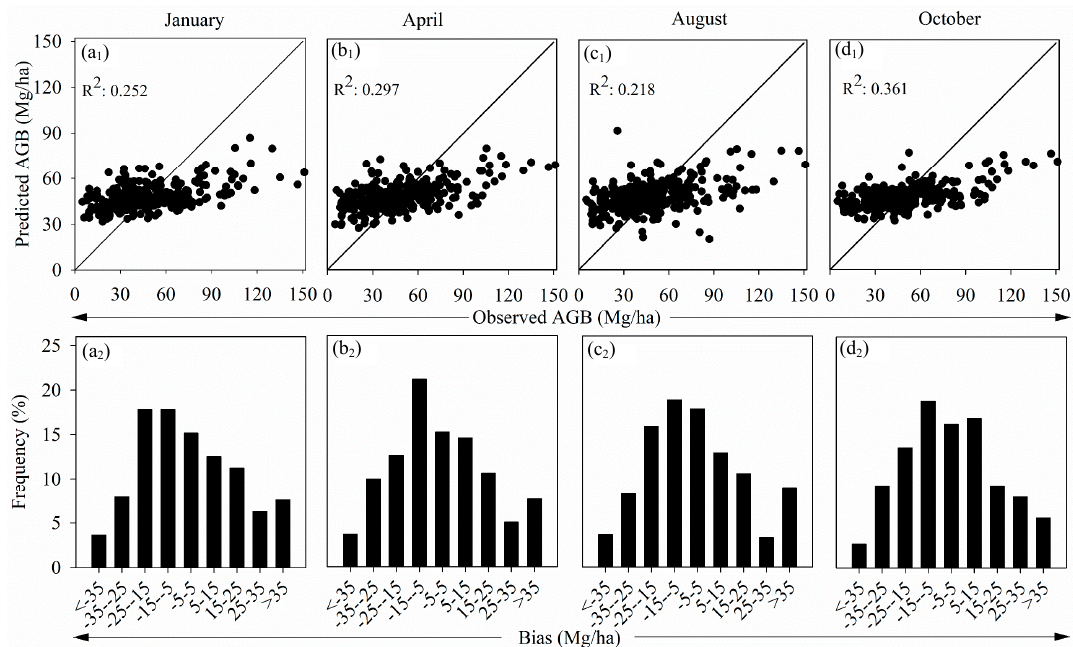
Figure 3. Model performances were evaluated using 10-fold cross validation and predicted AGB values were compared to observed AGB values using accuracy indicators. Scatterplots depict the relationship between predicted and observed AGB estimation values in each month ( a1 – d1 ). Histograms depict model biases ( a2 – d2 ).